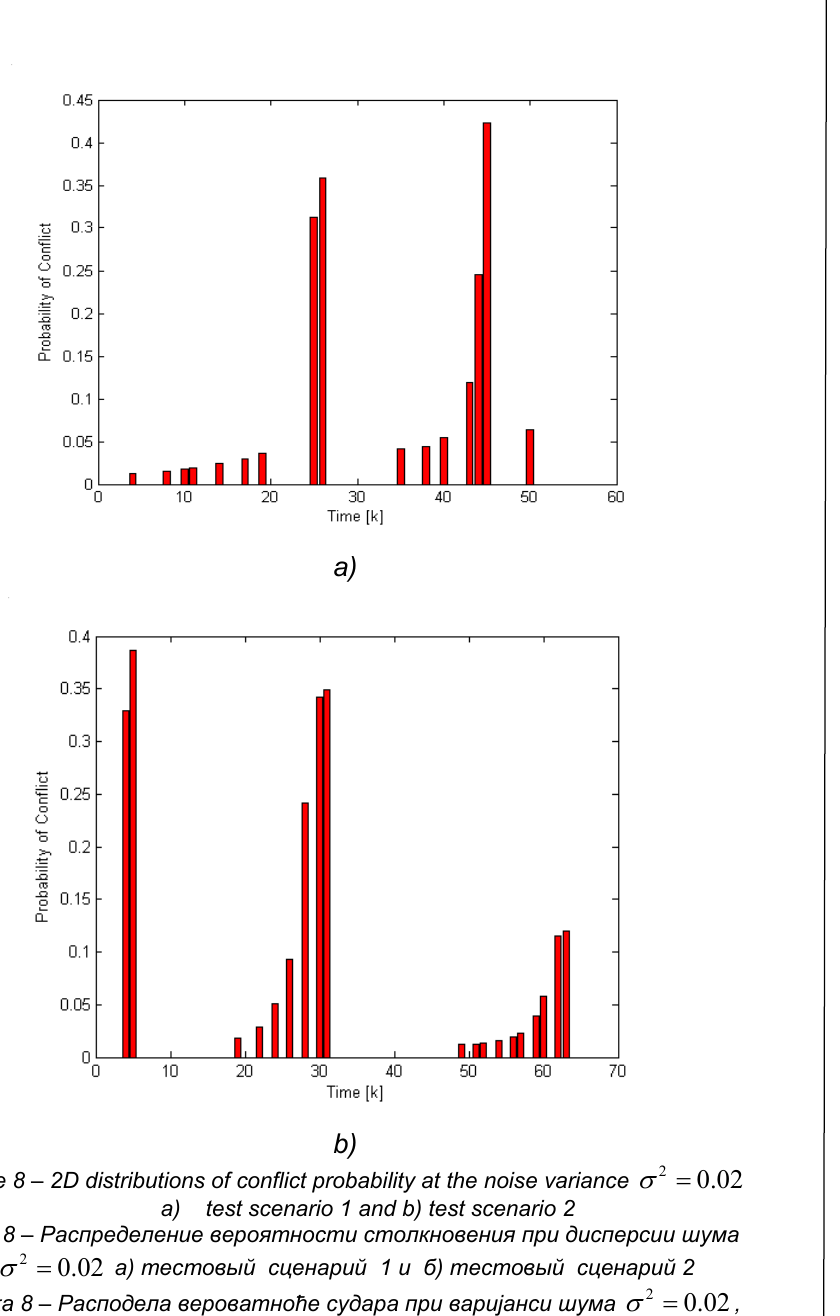
Figure 8 – 2D distributions of conflict probability at the noise variance 02.0 2   a) test scenario 1 and b) test scenario 2 Рис . 8 – Распределение вероятности столкновения при дисперсии шума 02.0 2 